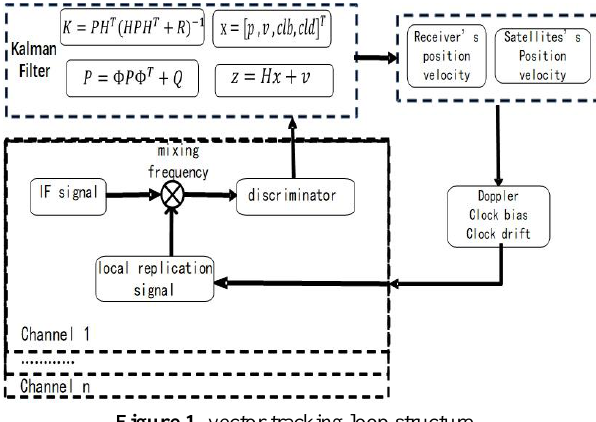
Figure 1. vector tracking loop